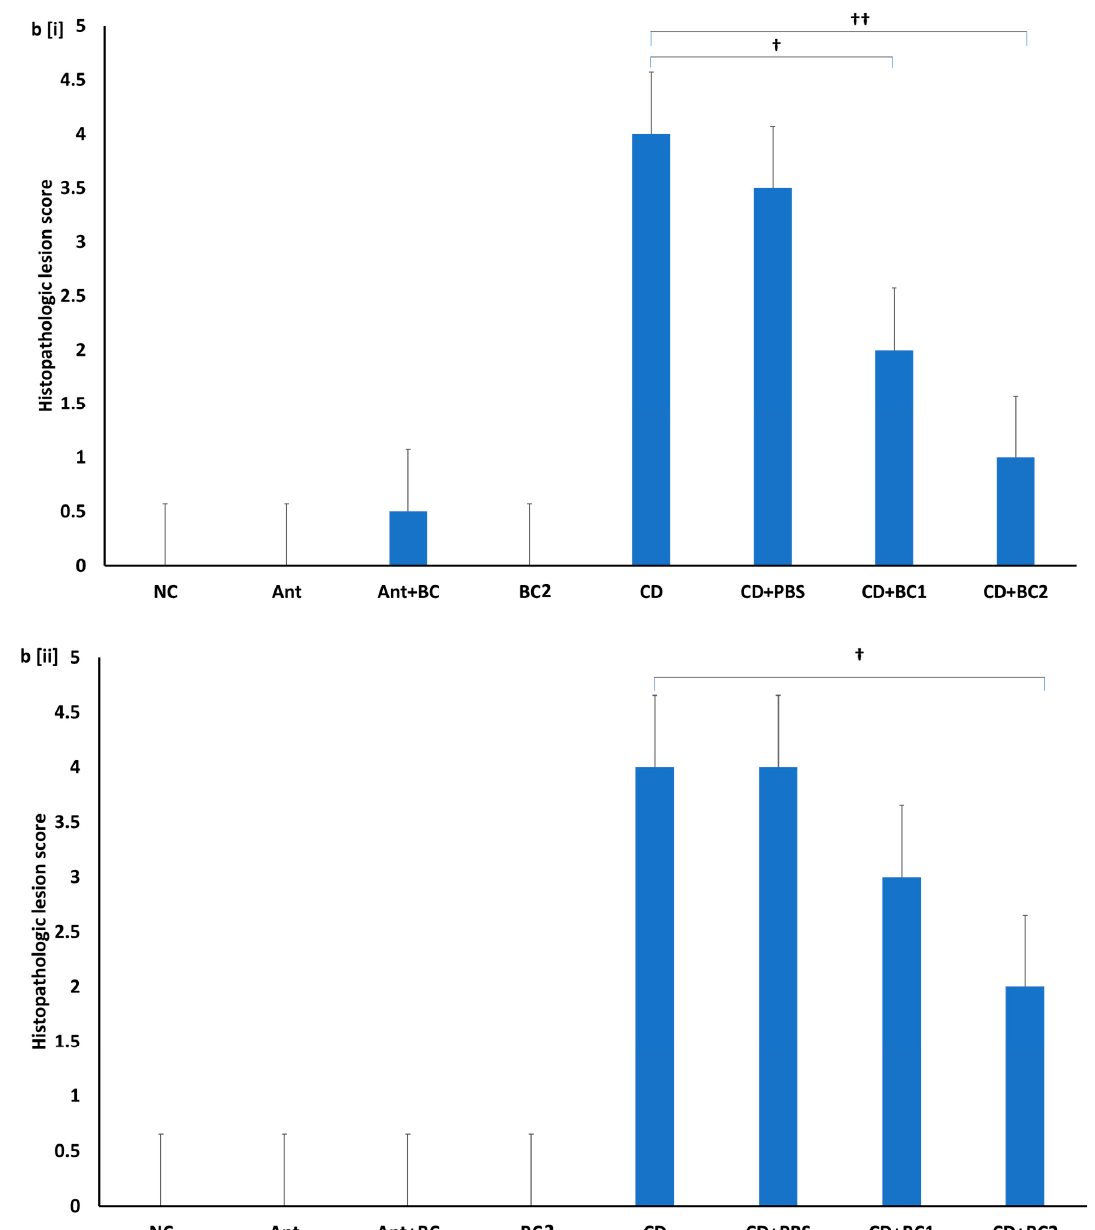
Figure 4. Colon histology and lesion scores. ( a ) Histologic examination of representative colonic tissues; (i) NC group— normal colon appearance; (ii) CD+BC1 group—colitis with submucosal and lamina propria inflammation (arrowhead) and moderate submucosal edema with dilated lymphatics (arrow); (iii,iv) CD+BC2 group—moderate colitis with submucosal edema (arrow), inflammation composed predominantly of neutrophils (arrowhead), and inset in (iv) shows neutrophils in higher magnifications (60×), which are predominantly inflammatory cells observed in the lamina propria and submucosa; (v,vi) CD group—severe colitis with marked submucosal protein-rich edema (arrow) congestion (thick arrow) and hemorrhage, enterocyte necrosis (asterisk) and erosion, and marked neutrophil infiltration (arrowhead). ( b ) Histopathologic scoring was based on (1) epithelial tissue damage; (2) congestion, edema, and hemorrhage; and (3) neutrophil infiltration. A score of 0–4 was assigned to each animal, denoting 0 for the absence of lesion, 1 for minimal, 2 for mild, 3 for moderate, and 4 for the severe histopathologic lesion. Mean of individual category scores were calculated to provide an overall histopathologic lesion score for each mouse and then for each group. Error bars represent SEM. (i) Prophylactic study; (ii) therapeutic study. ††, † symbol indicates a statistically significant difference ( p < 0.001, p < 0.05, respectively) relative to challenged, positive control (CD) vs. the baicalin-treated challenged mice (CD+BC1 or